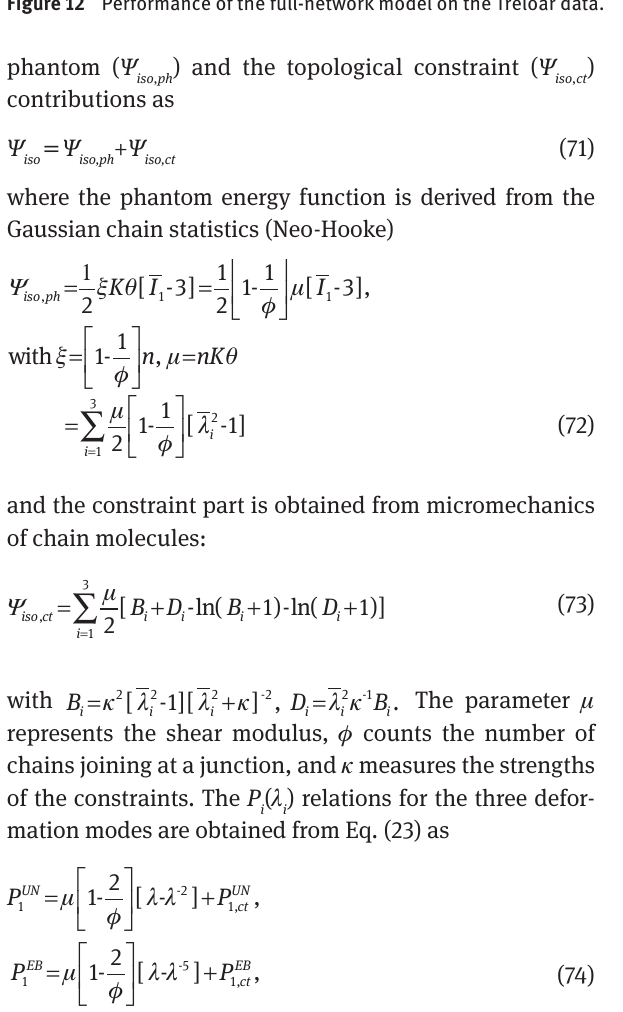
Figure 12 Performance of the full-network model on the Treloar